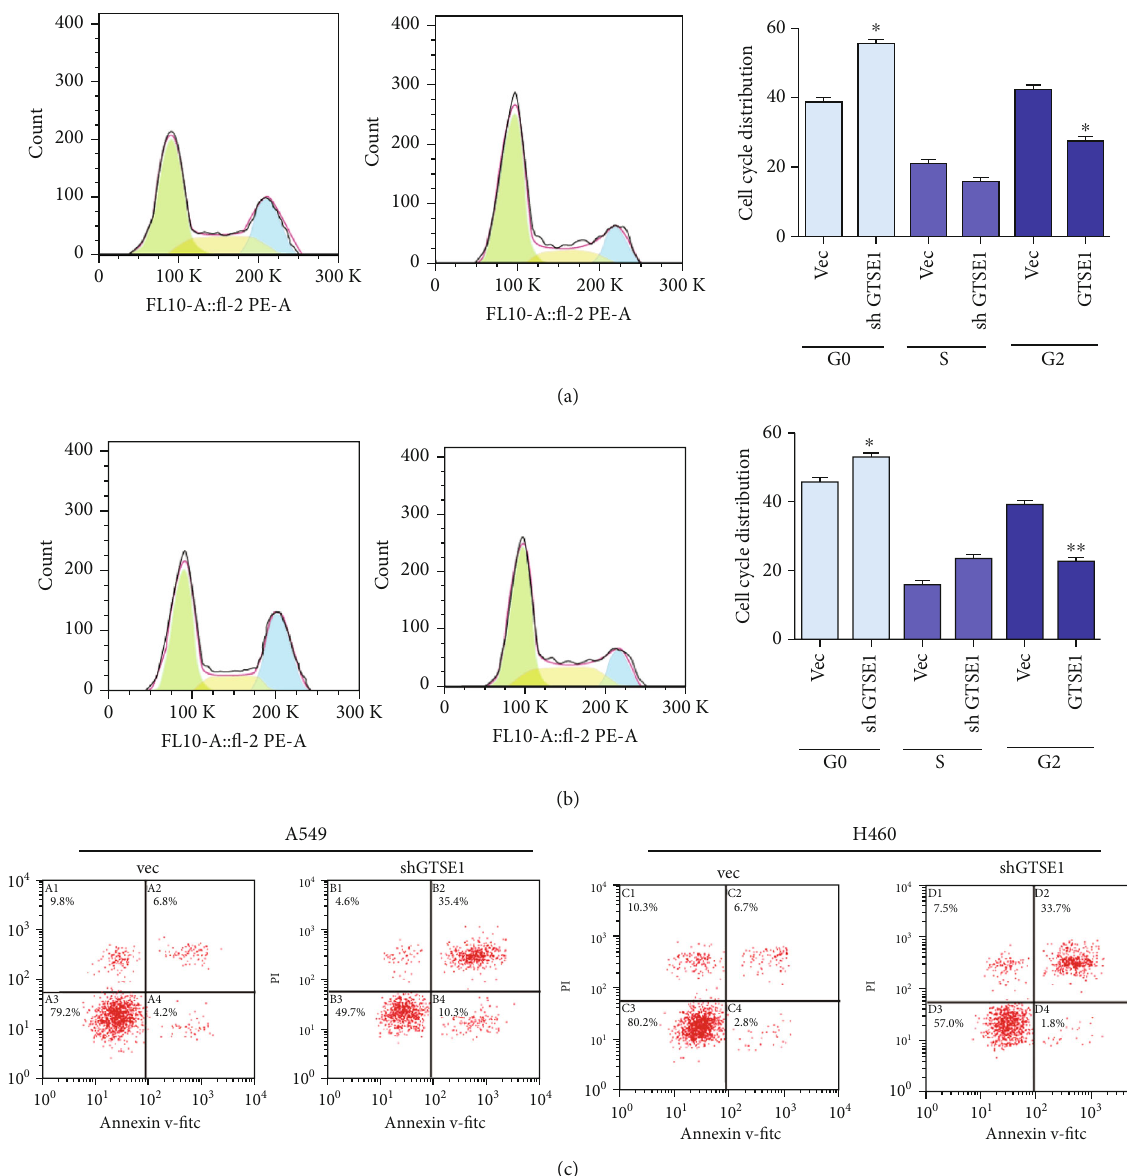
Figure 5: Deletion of GTSE1 inhibits the cell cycle and cell apoptosis induced in A549 and H460 cell lines. (a – c) GTSE1 was silenced in A549 and H460 cells. The cell cycle (a, b) and cell apoptosis (c) were analyzed by fl ow cytometry. ∗ p < 0 : 05 and ∗∗ p < 0 : 01